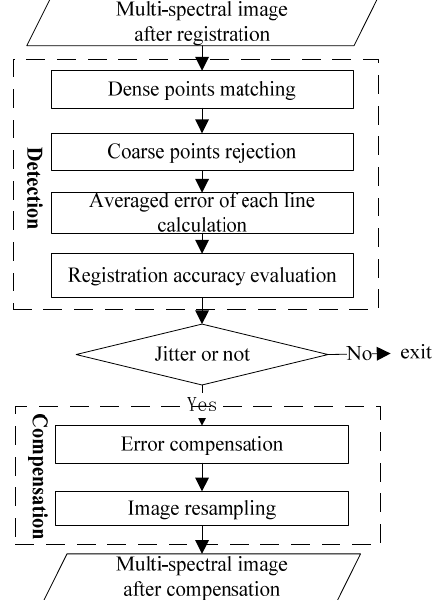
Figure 4. The flow chart of jitter detection and compensation